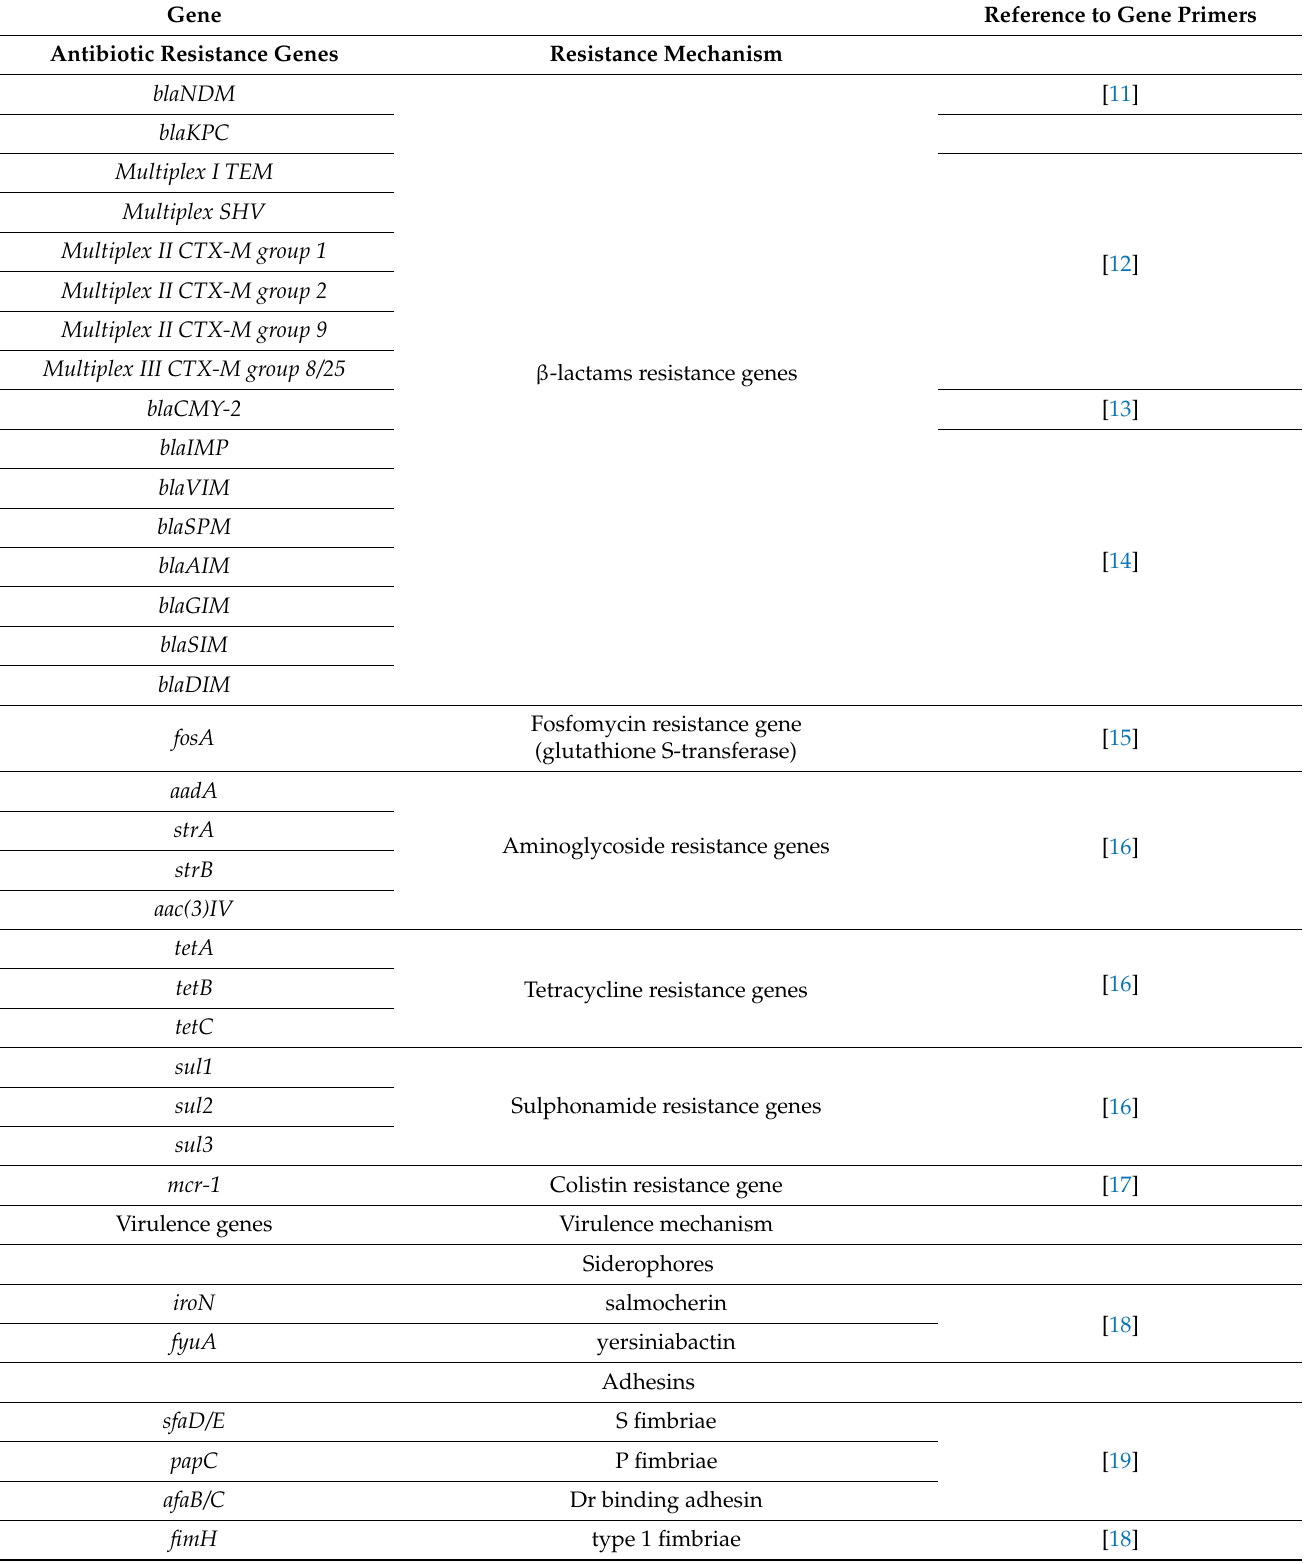
Table 1. Characterization of genes associated with antibiotic resistance and